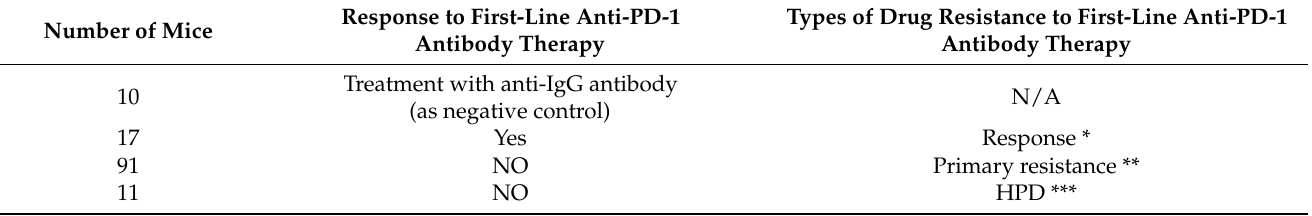
Table 3. Male Balb/c mice ( n = 129) bearing subcutaneous CT26 tumors treated with first-line anti-PD-1 therapy and anti-IgG (as negative control) antibody (2.5 mg/kg) once every 3 days for 3 doses.